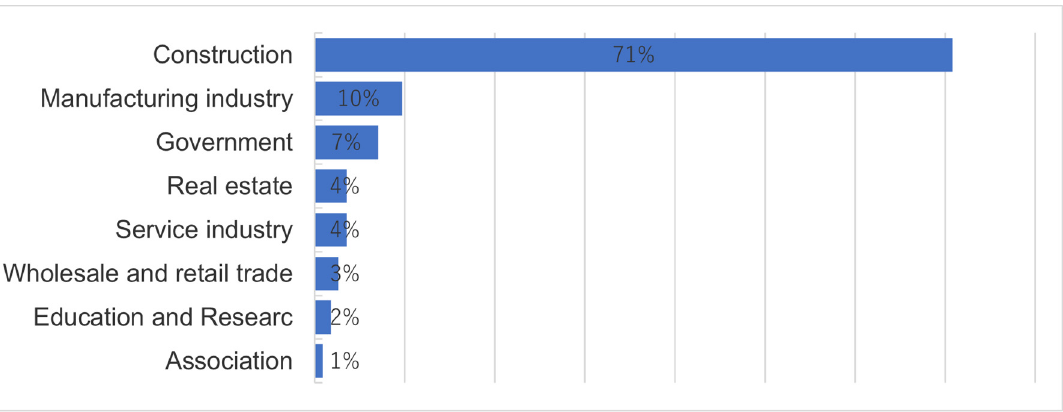
Figure 5. Business sectors.